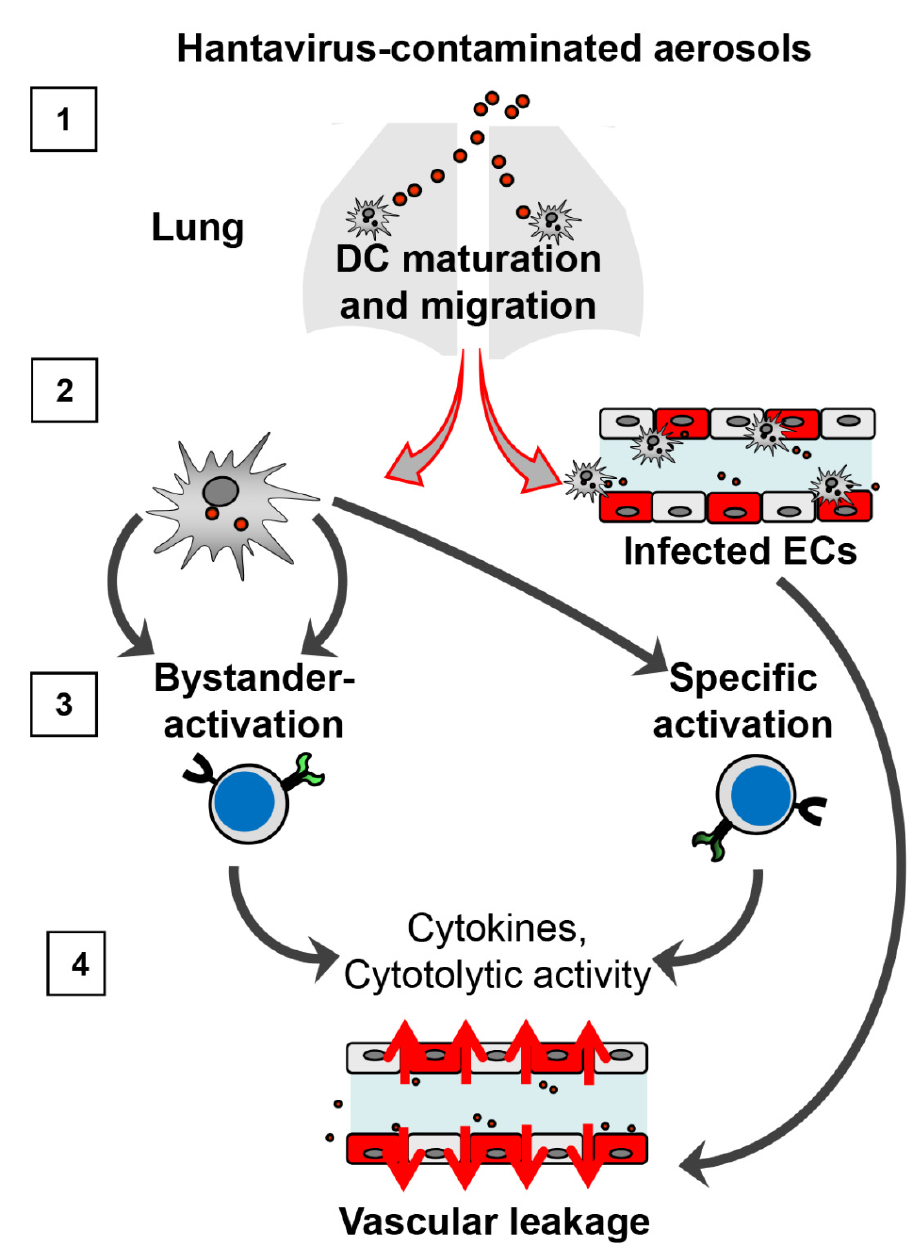
Figure 1. Dendritic cells (DCs) as “fire accelerants” in hantavirus-induced pathogenesis. (1) After inhalation, pathogenic hantaviruses may productively infect DC subsets in close contact with the respiratory epithelium/alveolar interstitium, thereby inducing DC maturation and migration. (2) Hantavirus-infected DCs can act as shuttles that safely transport virions to endothelial cells (ECs), the main arena of hantavirus-induced pathogenesis, resulting in vascular leakage, and lymphoid tissue, where immune cells are activated. (3) Hantaviruses-infected DCs cause massive bystander activation of immune cells (CD8+ T cells, B cells, NK cells). Bystander-activated immune cells may in turn license